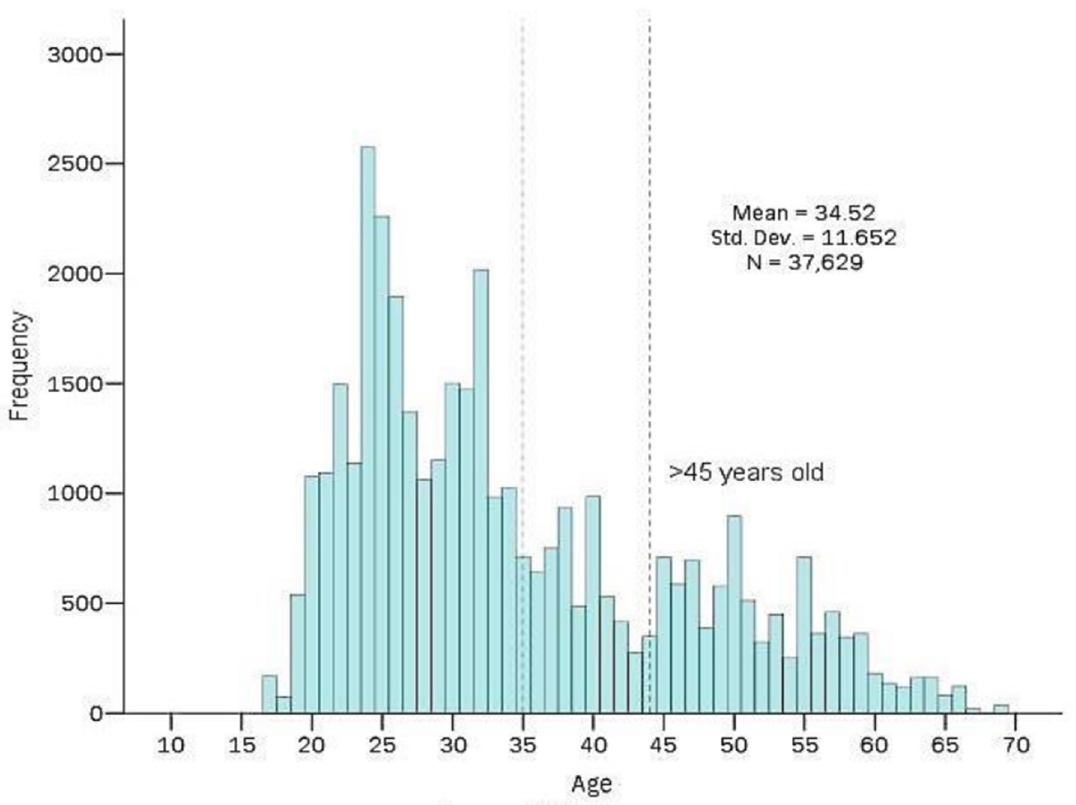
Figure 4. Distribution of precarious workers by age (2019). Data source: EU-SILC (2020).